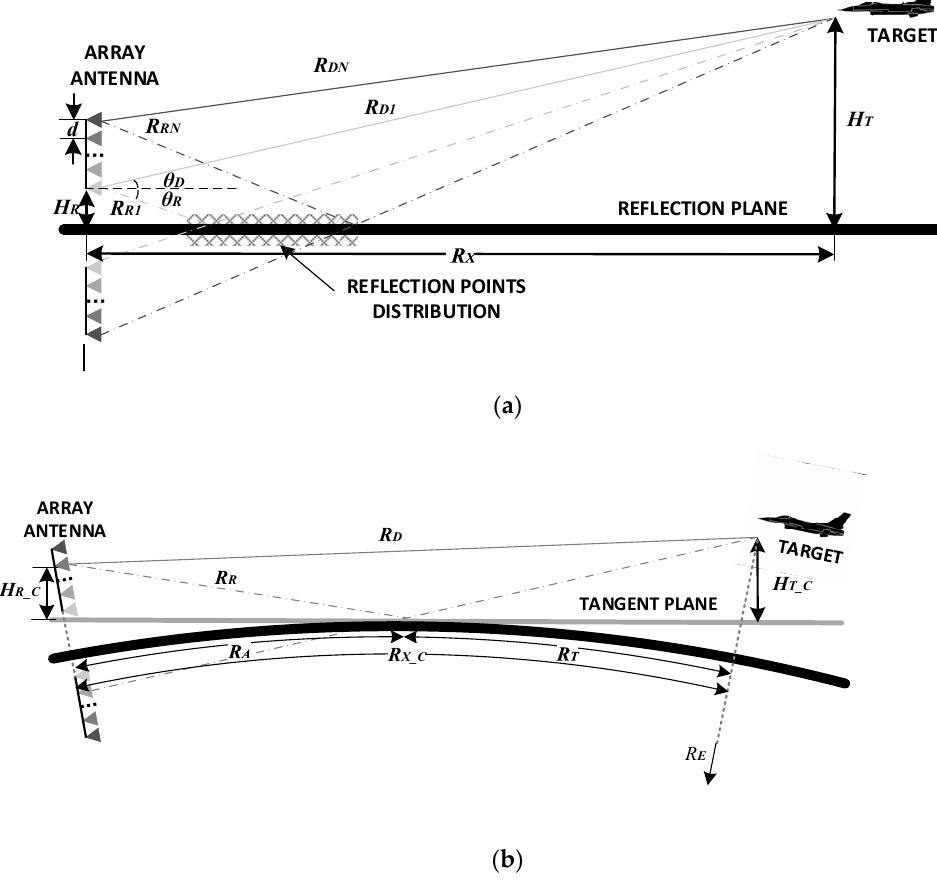
Figure 1. The geometry of the multipath propagation model. ( a ) Flat-Earth model; ( b ) Curved-Earth model.